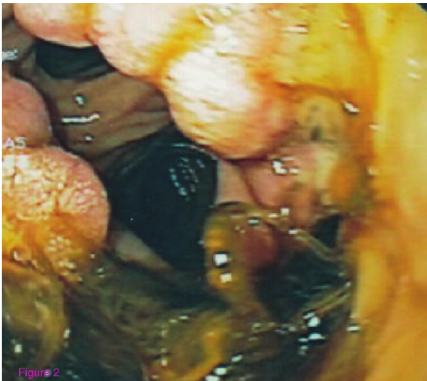
Figure 2: Endoscopic view of the